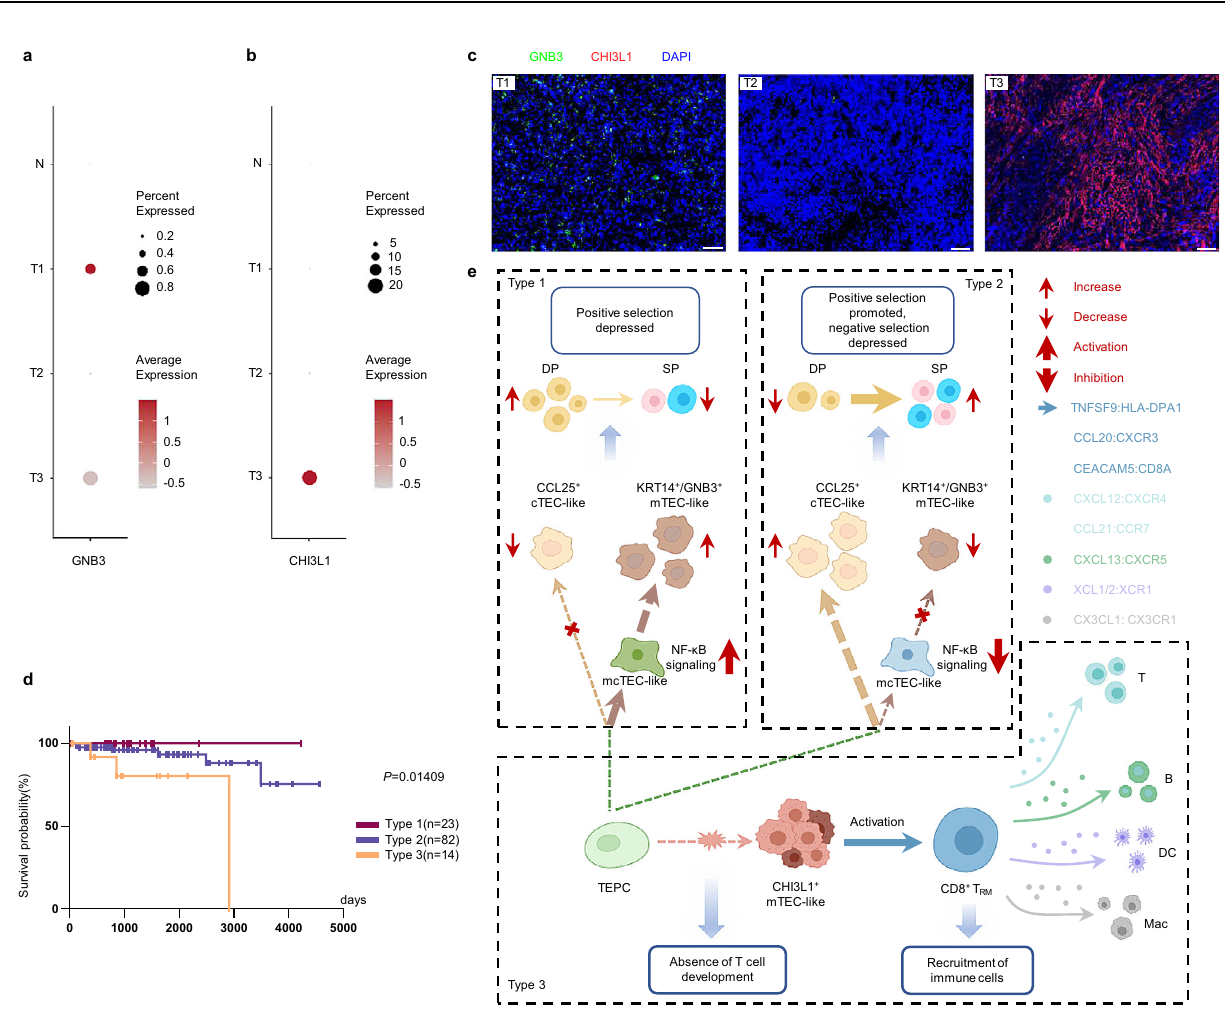
KEGG pathway analysis of genes that were signi fi cantly ( P < 0.01) upregulated in CD8 + T RM cells compared to other T cells. ( l ) Heatmap of chemokine interactions among CD8 + T RM cells and other cell types, normalized per column. ( m – n ) Flow cytometric analysis of CXCL13 expression among CD4 + T cells, CD8 + non-T RM cells andCD8 + T RM cellsinTETs.( o – p )RepresentativeIFstainingimagesshowingCD103 (red), EPCAM (green), CD11c (green), CD20 (pale blue) and DAPI (nuclei, blue) in type 3 TET samples. The interactions between epithelial cells and T RM cells are indicated by white arrows ( o ). The interactions between T RM cells and DCs are indicated by yellow arrows, and those between T RM cells and B cells are indicated by white arrows ( p ). Scale bar: 20 μ m. Experiment was performed in three independent samples with similar results. ( f , j , n ) n=8 (f) , 8 (j-left) , 6 (j-right) , 6 (n) , respectively. Data are presented as the mean±s.e.m. P values in the fi gure weredeterminedbyatwo-tailedpairedStudent ’ sttest.Sourcedataareprovidedas a Source Data fi le.